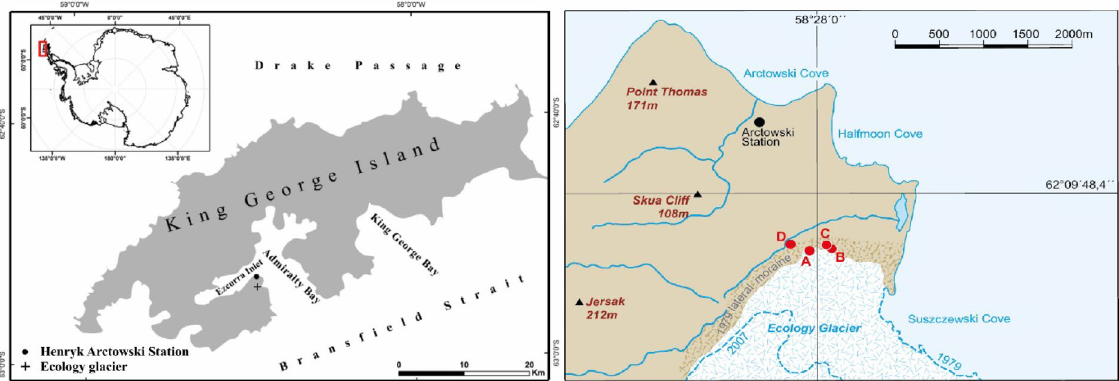
Figure 1. Location of the study sites. Soil profile locations close to the Ecology Glacier are marked as red dots. Soil profiles A, B, and C are located in the glacier foreland deglaciated after 1979 33 . Profile D is located distal to the lateral moraine. The dashed blue lines indicate the glacier front in 1979 and 2007 50 (source: Orthophotomap from 2007, Department of Antarctic Biology, Polish Acadamy of